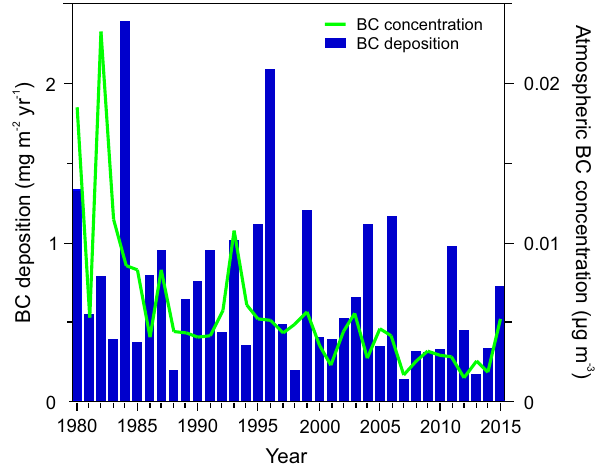
Figure 6. Modelled annual BC deposition and atmospheric concen- trations at